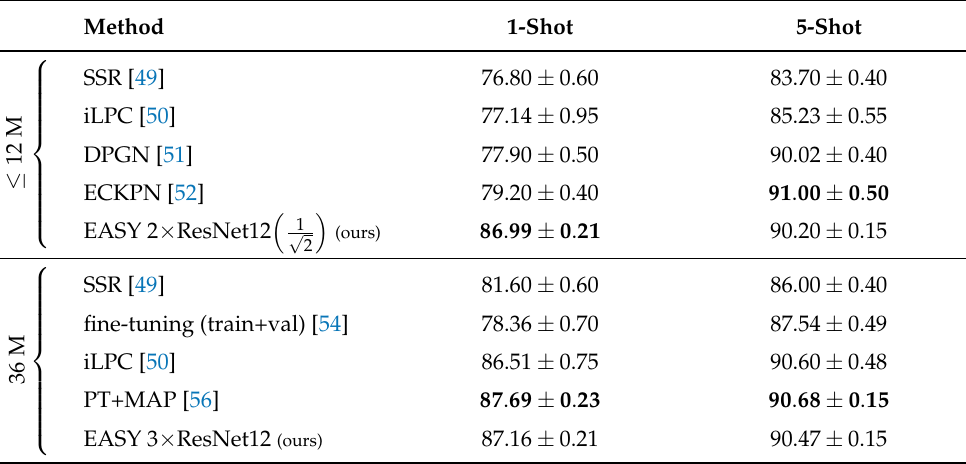
Table 9. The 1-shot and 5-shot accuracy of state-of-the-art methods and the proposed solution on CIFAR-FS in the transductive